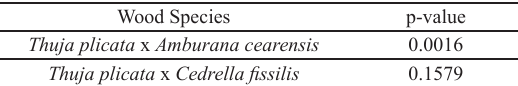
Table 4. Relation between apparent densities.